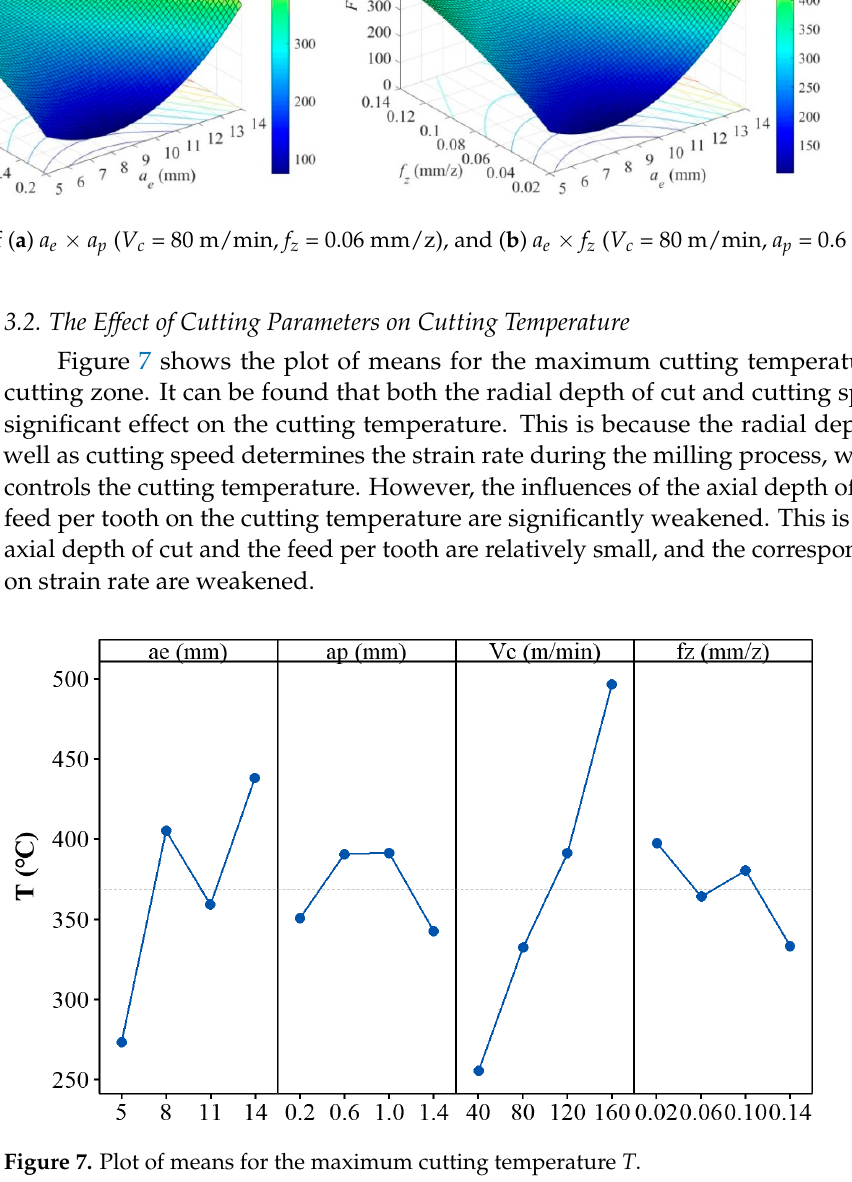
Figure 8. Experimental data [L 16 (4 4 )] and fitting results of maximum cutting temperature T . Table 4. ANOVA for maximum cutting temperature. Parameters